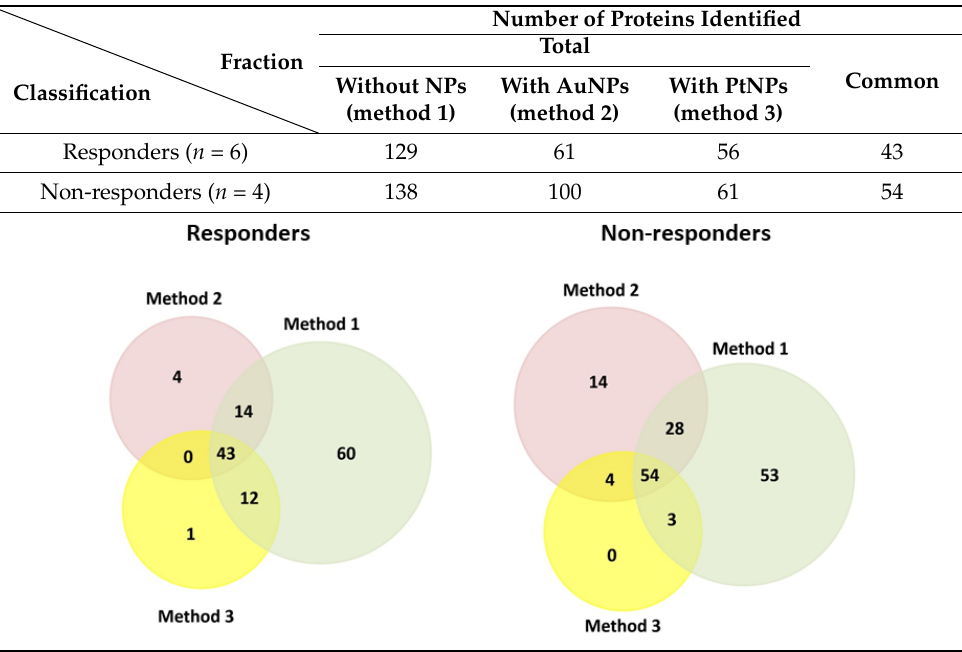
Table 2. Venn diagrams and table showing the number of proteins identified in the sera of HER2- positive BC patients ( n = 6 responders, n = 4 non-responders) obtained before NAC by each treatment method and common to the three methods ( method 1: analysis of the crude serum; method 2: AuNPs-PC analysis; method 3: PtNPs-PC analysis).